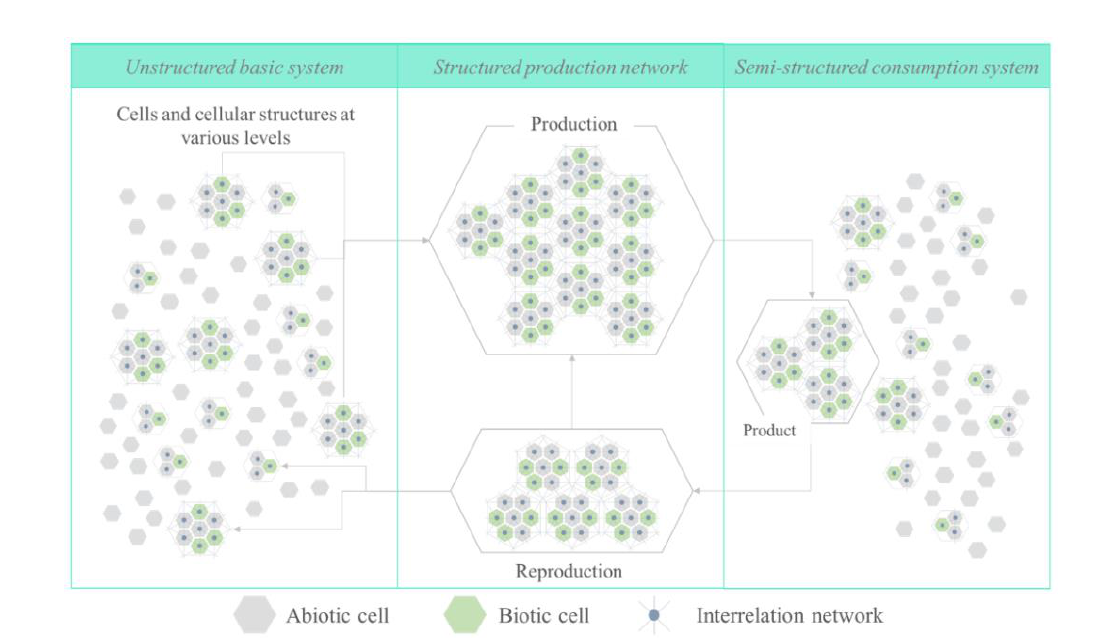
Figure 4. Thought model for the description of biointelligent Business Models (BMs).